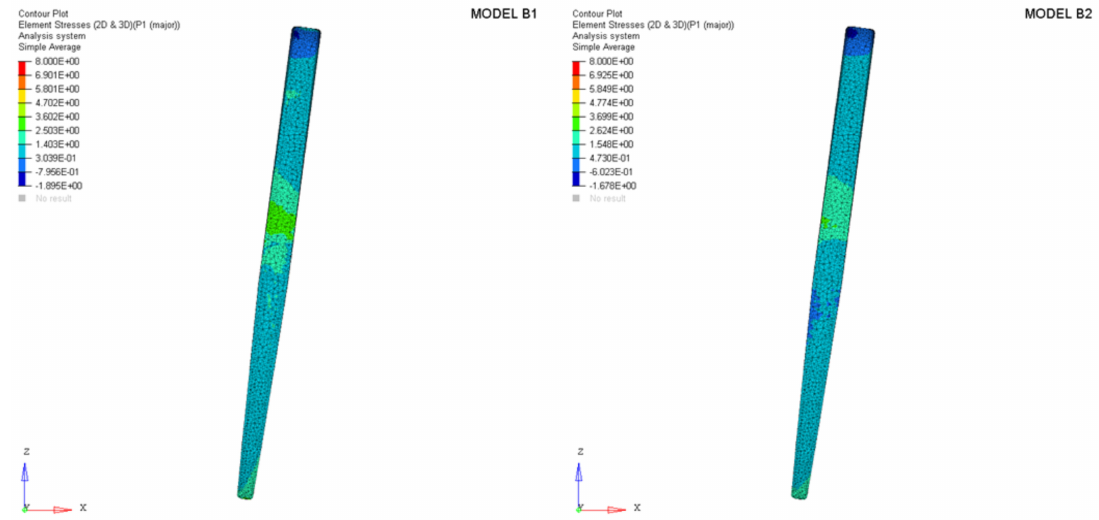
Figure 6. Models B1 and B2: Maximum principal stress distribution (MPa). The color scale was chosen to allow for comparison among the analyzed